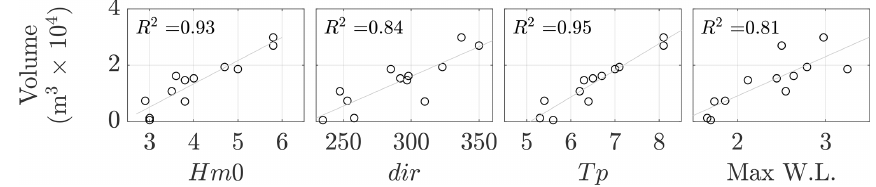
, T p , dir, and maximum water level) against total 0